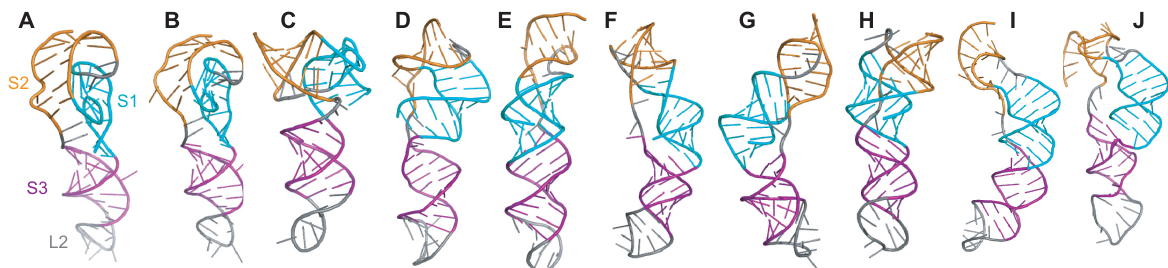
Fig 2. Blind predictions of pseudoknot structure. Structures predicted by (A) RNAvista, (B) RNAComposer, (C–E) SimRNA, (F–H) Rosetta FARFAR2, (I, J) Vfold. In each case, secondary structure is color-coded (S1: cyan, S2: orange, S3: purple, loops: grey).